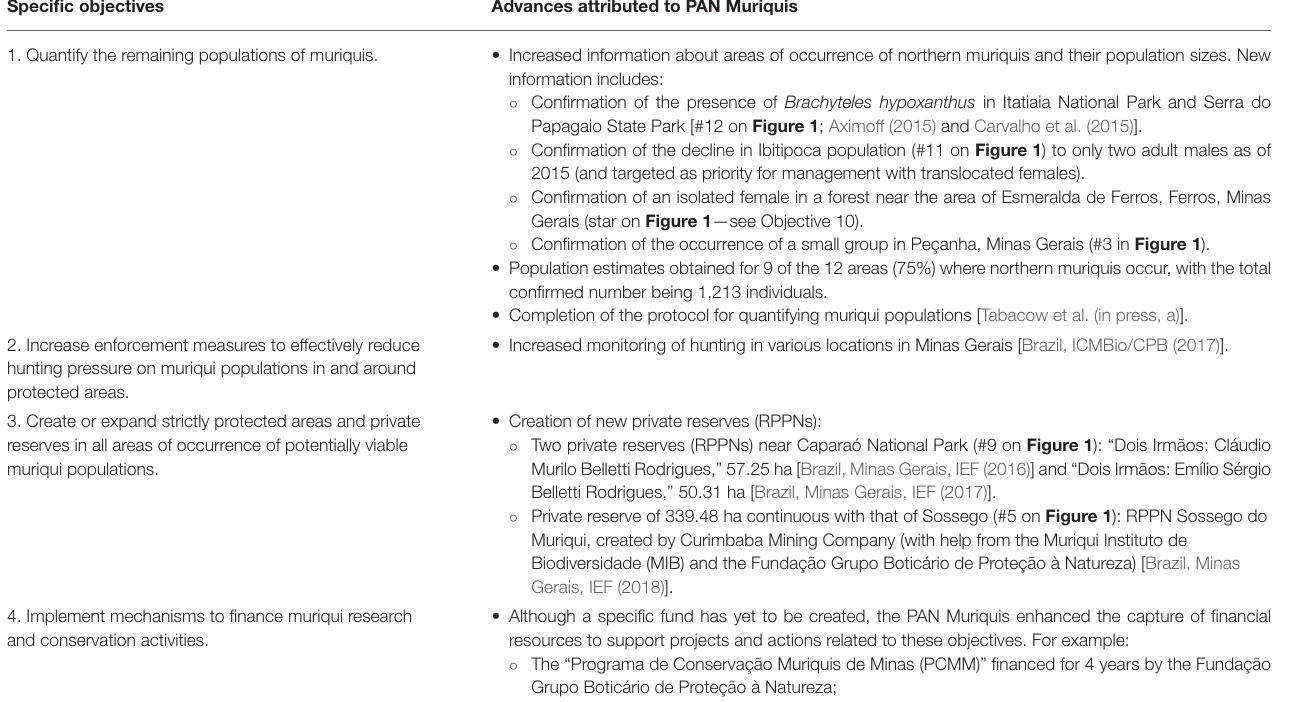
TABLE 1 | Advances following the adoption of the PAN Muriquis concerning ongoing conservation initiatives for the northern muriqui, Brachyteles hypoxanthus . Adapted from Brazil, ICMBio/CPB (2017). Specific